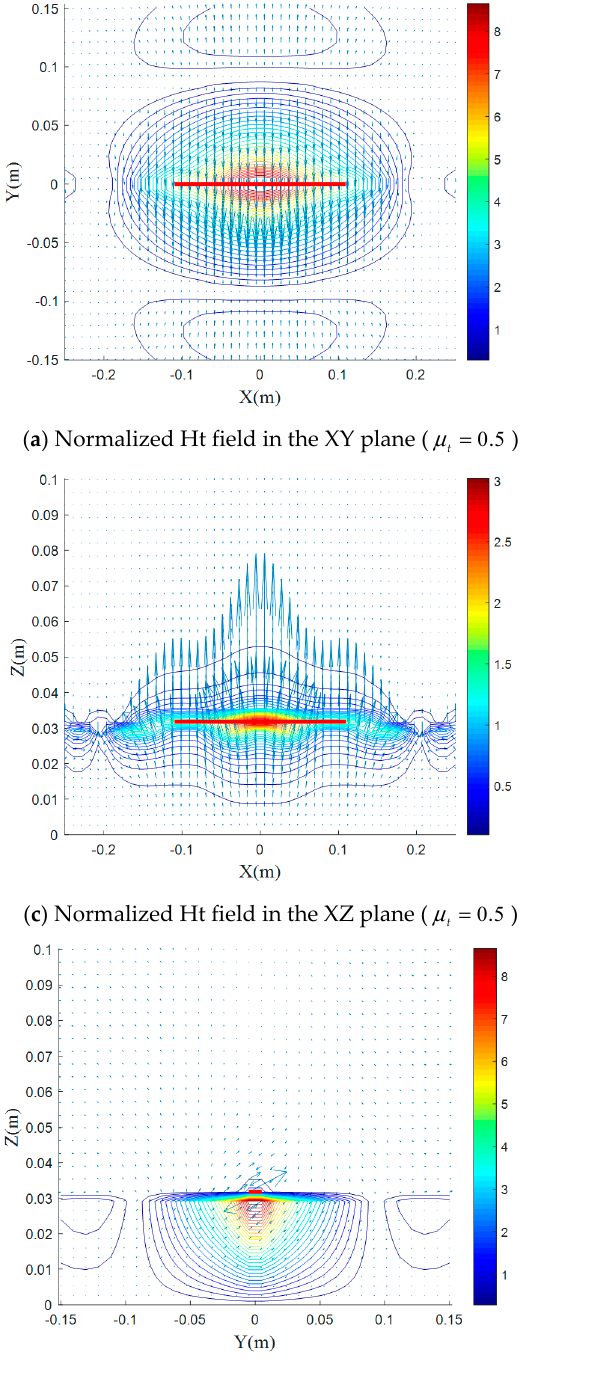
Figure 10. ( a – f ) Normalized magnetic field distributions for various values of XY, XZ, and YZ plane.